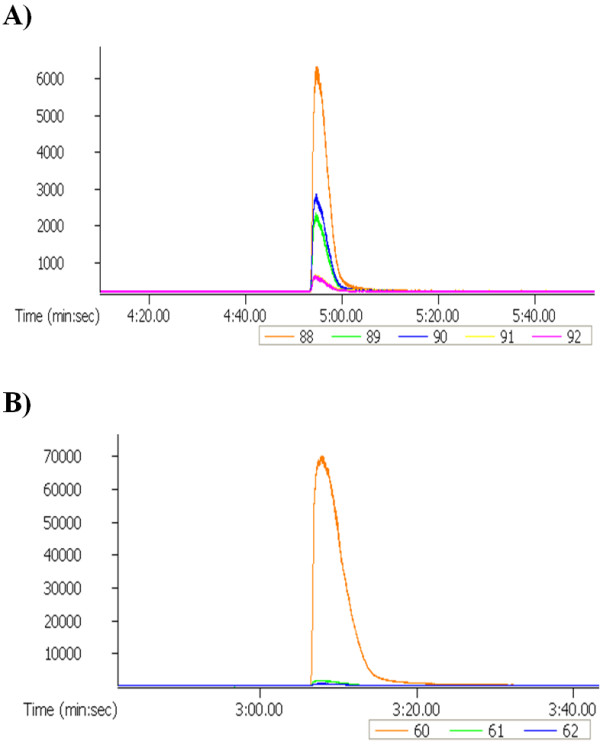
GC-MS spectra of acetic and butyric acids present in the culture broth of C. tyrobutyricum ATCC 25755T after culturing for 40 h in P2 medium with 12C6-glucose (40.0 g/L) and [1,2,3-13C3] lactic acid (5.0 g/L). A) Mass spectra of butyric acid showing the presence of significant amounts of butyric acid with molecular weights higher than 88 (i.e.: 89, 90, 91 and 92) indicating the corporation of 13C. B) Mass spectra of acetic acid showing the absence of 13C in the acetic acid.